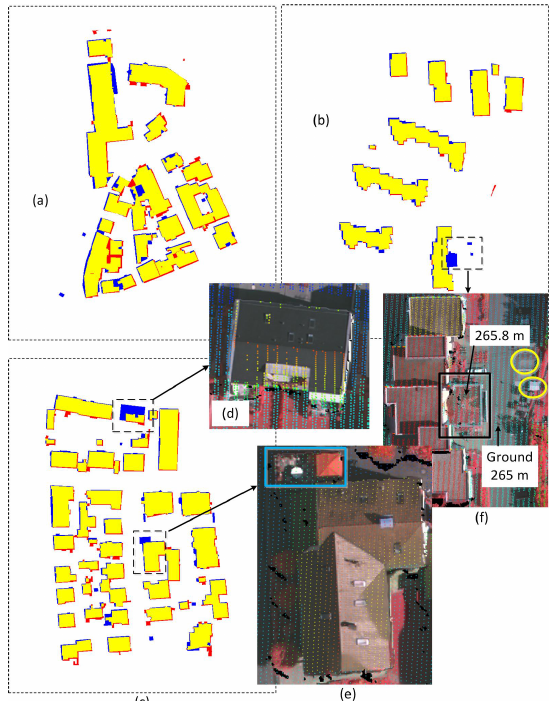
Figure 9: Building detection in the Vaihingen data set: (a) Area 1, (b) Area 2 and (c) Area 3. Some complex cases are shown in = l (d) to (f). Yellow = true positive, blue = false negative and red = false positive pixels.